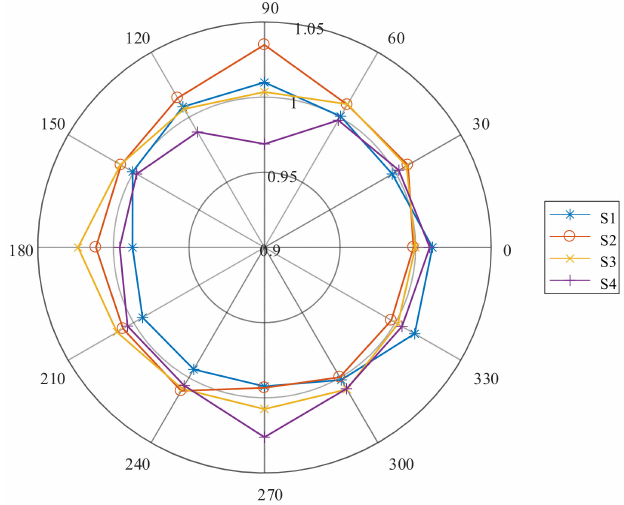
Figure 3. UHF sensor array radiation